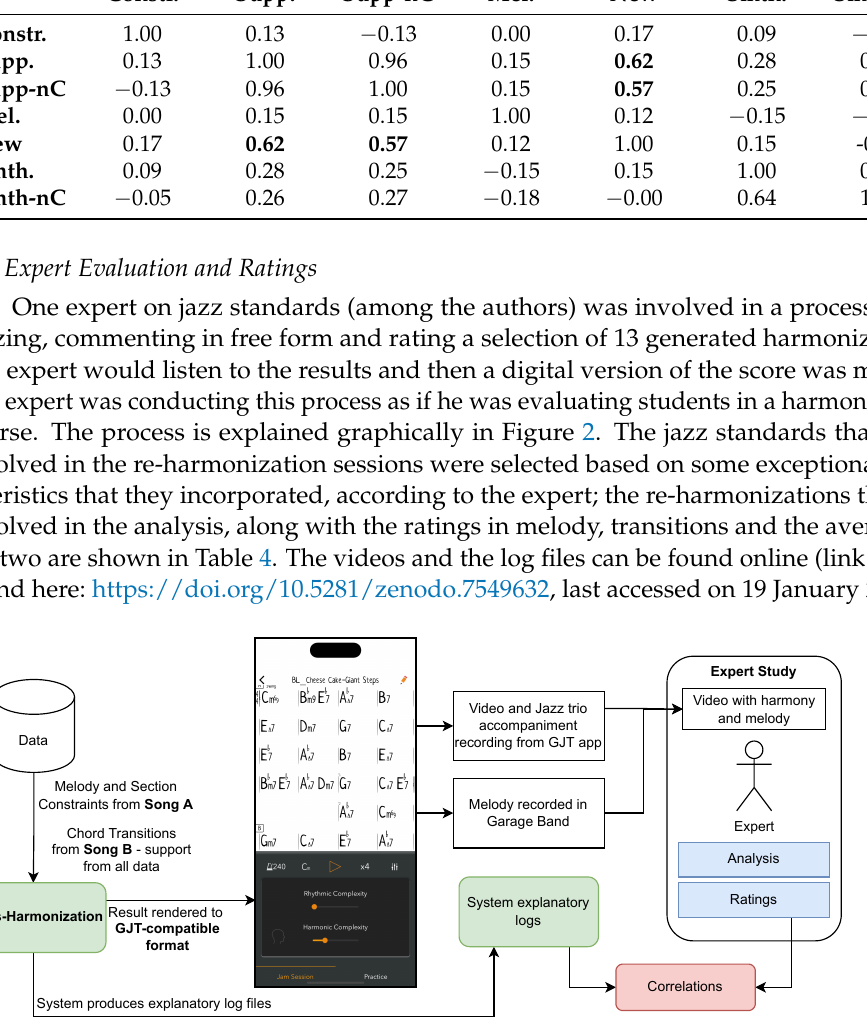
Table 3. Results of correlation analysis on all generated pieces, for examining relations between con- straints, support/smoothing (on constraints or independent), melody matching and the employment of new chords. The following features are examined (a value per feature for each piece): Constr. : ratio of constraints over transitions. Supp. / Smth. / New : ratio of times support/smoothing/appearance of new chord was presented over transitions. -nC suffix: not coming exactly before, after or over constraint. Mel : melody matching value (of O N × K ). Constr. Supp. Mel. Smth.